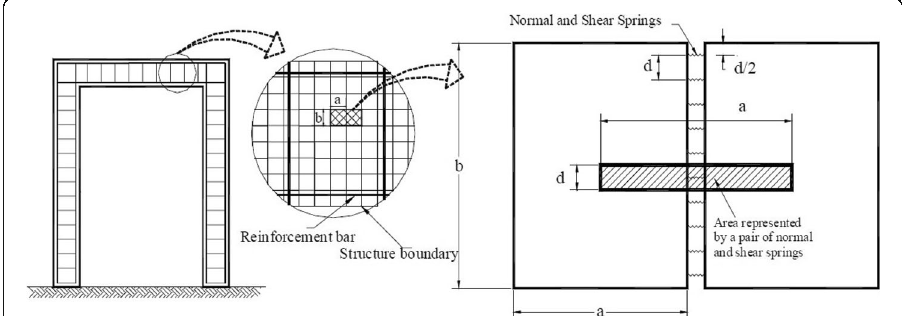
Fig. 2 Modelling of structure in the AEM [19]. a Element generation for AEM. b Spring distribution and area of influence of each pair of